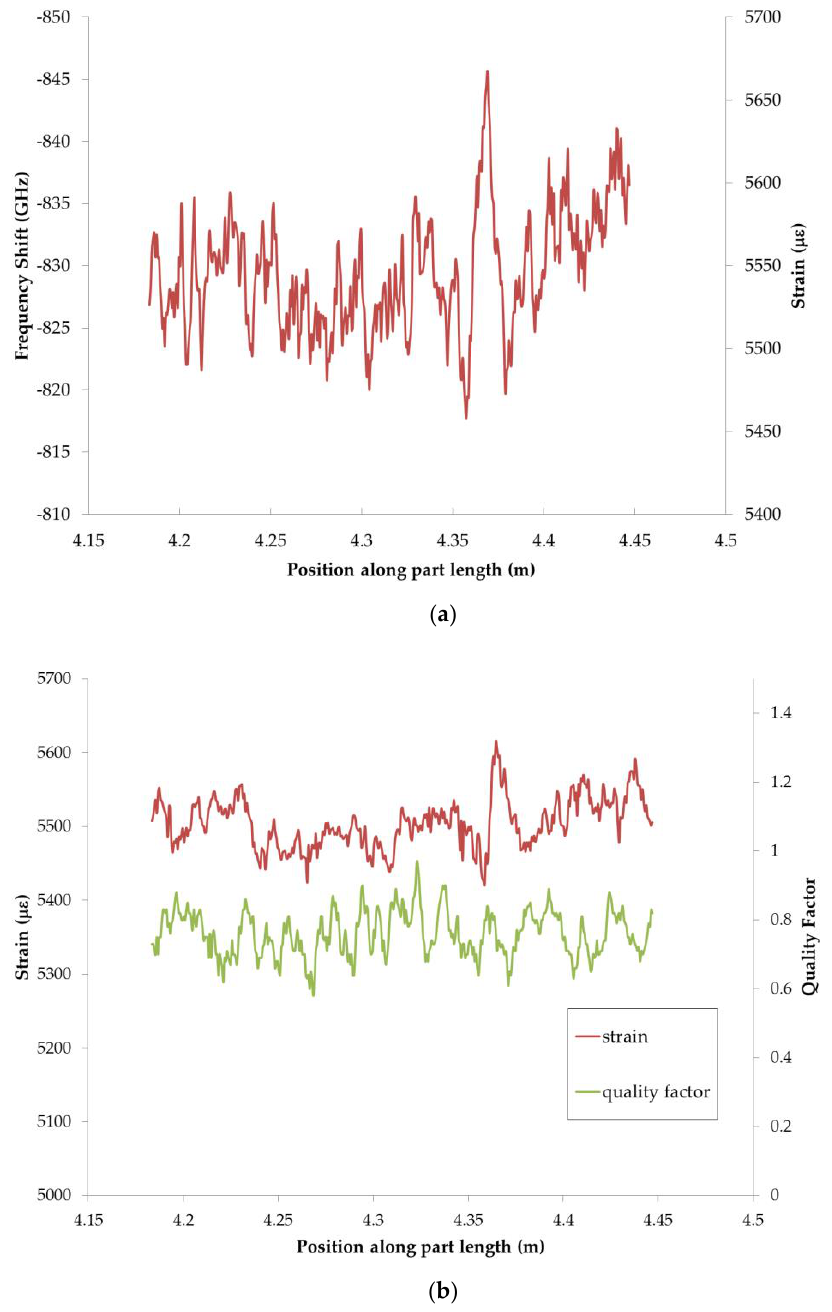
Figure 2. Graphical representations of ( a ) Rayleigh shift measured for section of the fiber sensor and ( b ) relationship of spectral quality factor corresponding to the strain values.